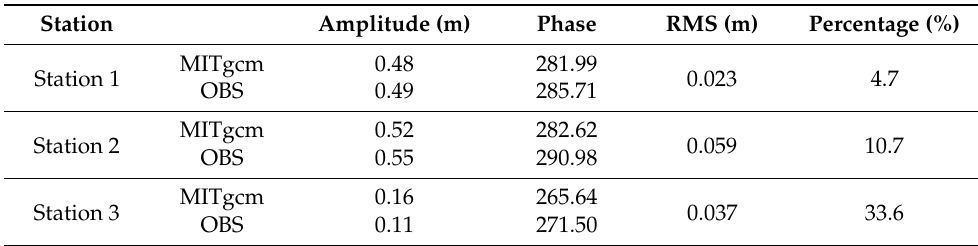
Table 1. Model simulated and observed M 2 barotropic tide amplitudes (m) and phases (degree) at three stations. The absolute RMS (m) and its percentage (%) are calculated.